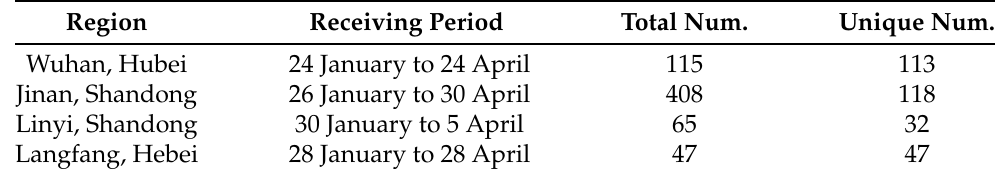
Table 9. Statistics of collected short message datasets. Region Receiving Period Total Num. Unique